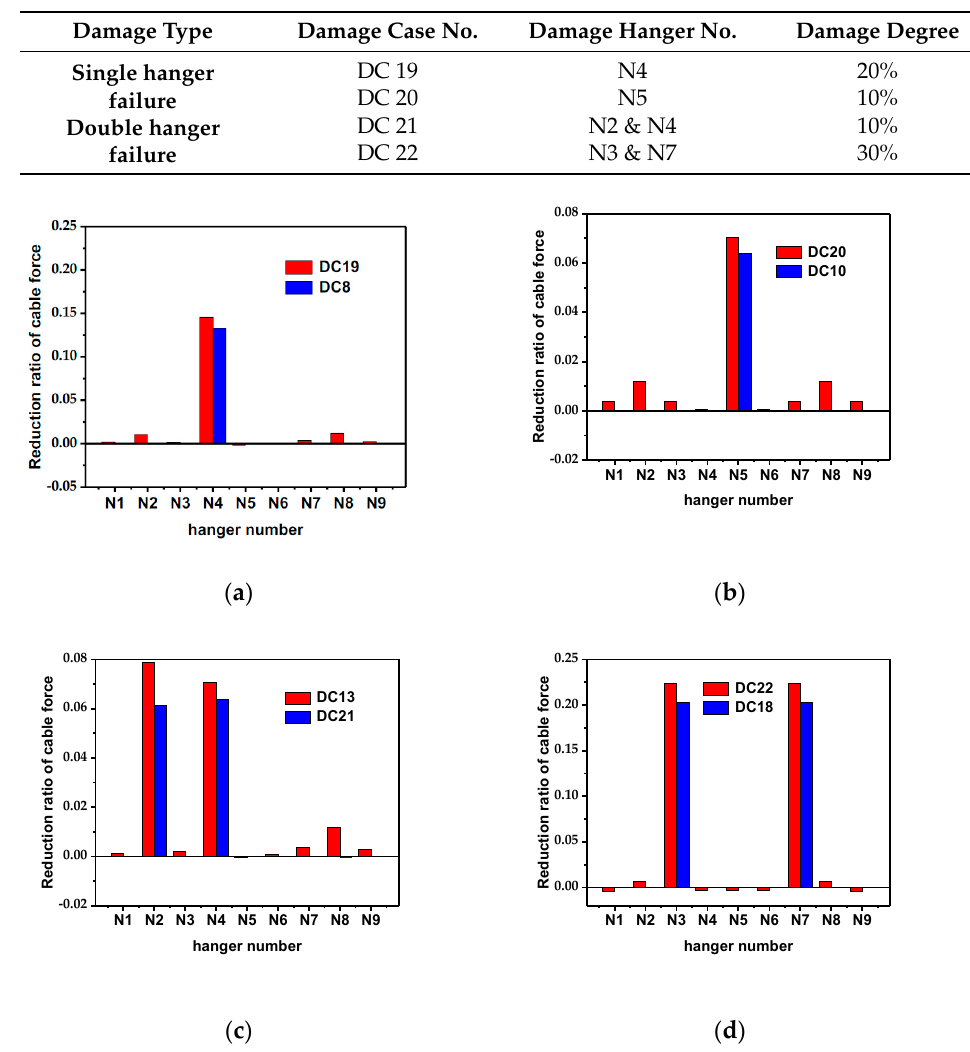
Table 4. Four damage conditions that considering the creep and stiffness degradation.